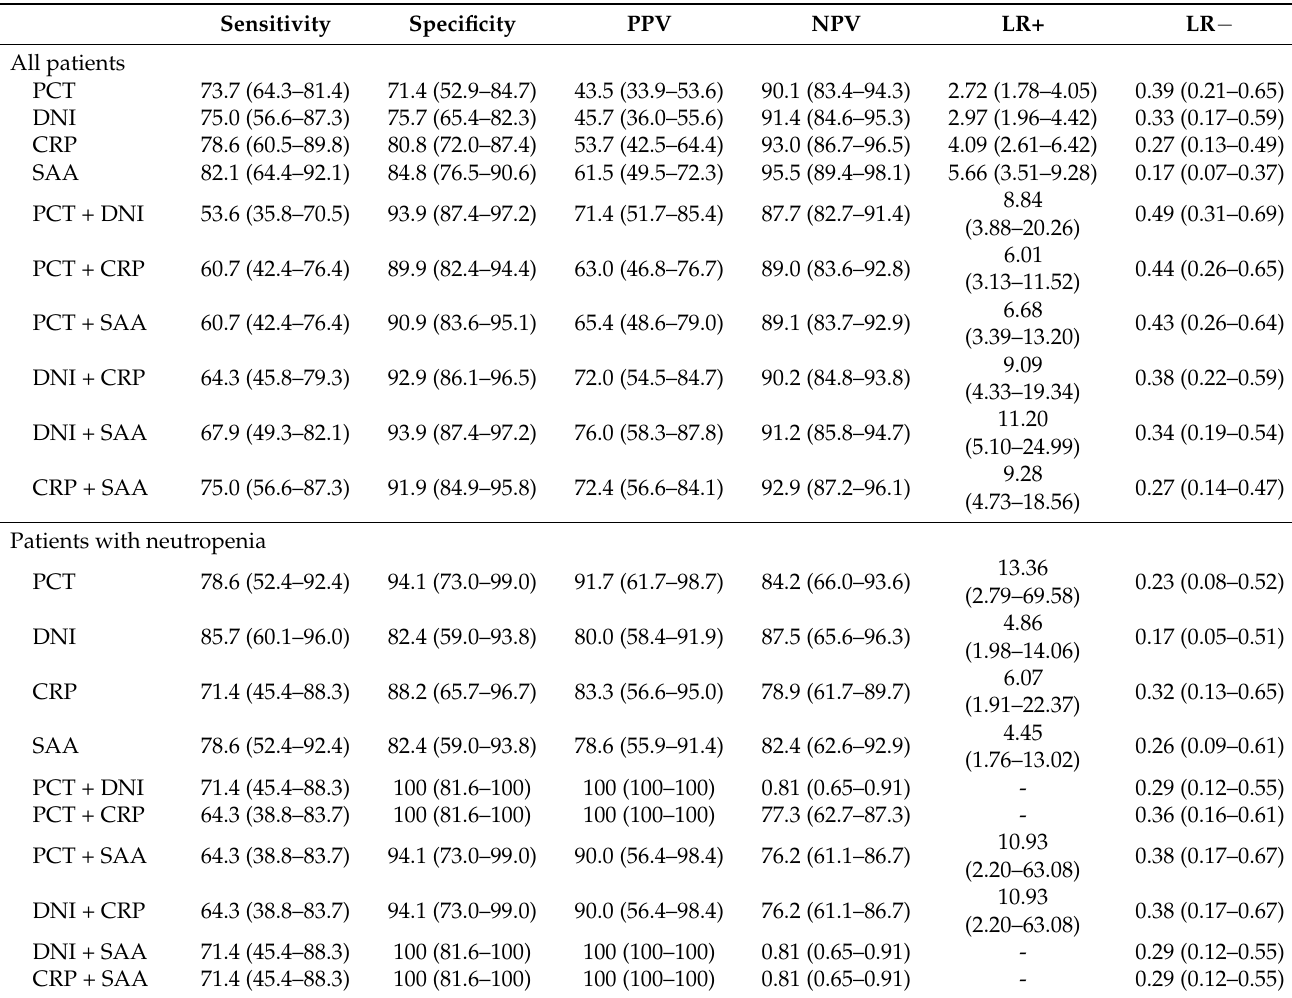
Table 3. Performance of each marker alone or in conjunction with other markers for the diagnosis of infection in all patients and patients with neutropenia (mean and 95% confidence